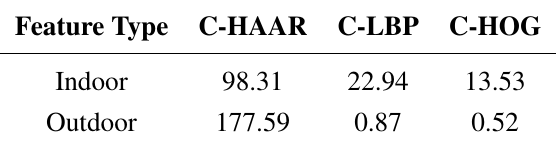
Figure 18. ( a ) Indoor and ( b ) outdoor training times consumed for each stage in the cascaded classifier. The y-axes are in log-scale. Table 5. Time spent for training the cascaded classifiers having 19 stages in